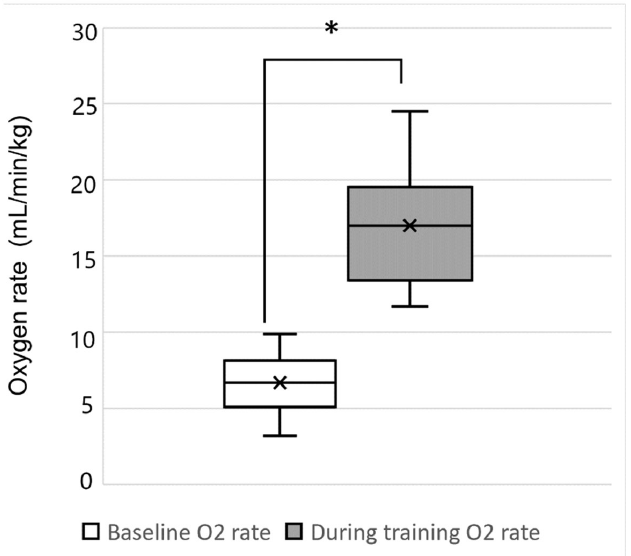
Figure 4. Oxygen rate of the resting when compared to resting state. Data were analyzed using paired t ‐ test. Values are shown as mean ± SD. * p < 0.05.